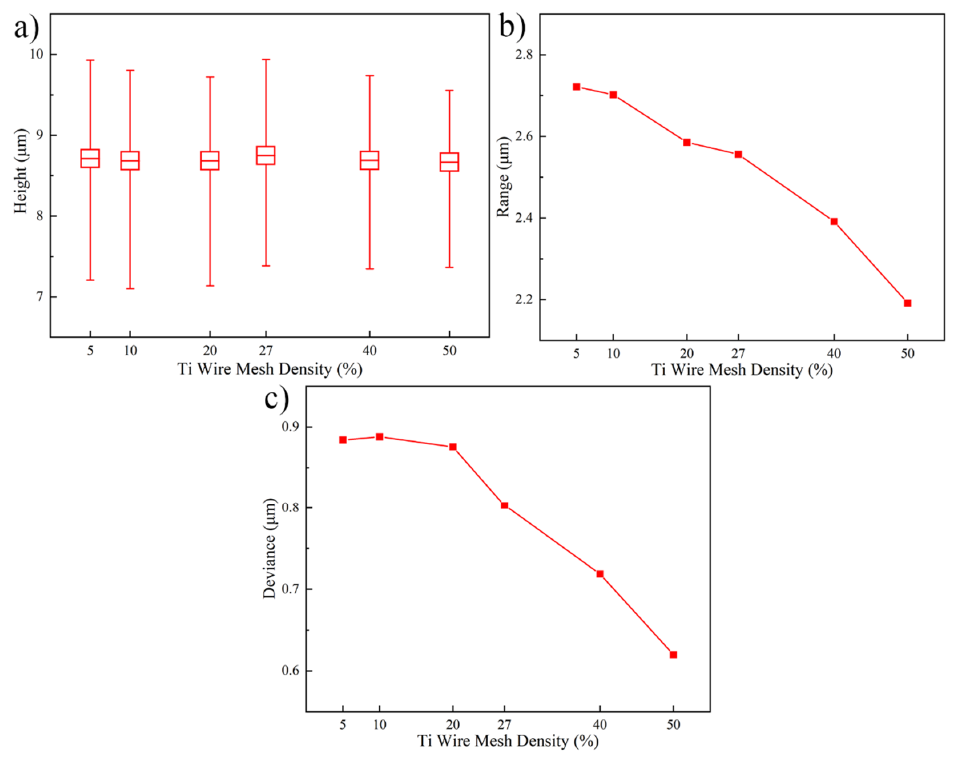
Figure 11. Au bump height and uniformity under different Ti wire mesh densities. ( a ) Au bump height, ( b ) Au bump range, and ( c ) Au bump deviance.